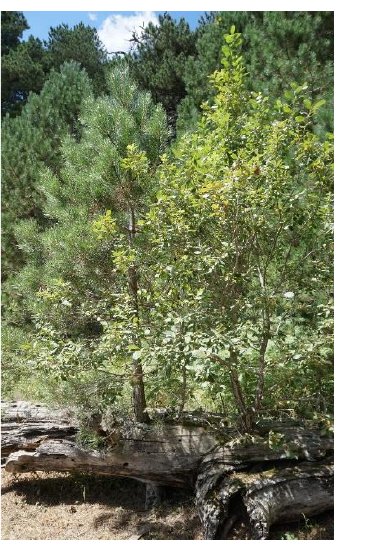
Figure 2. Deadwood provides a favorable environment for the regeneration of plant species and natural shelters for animals.